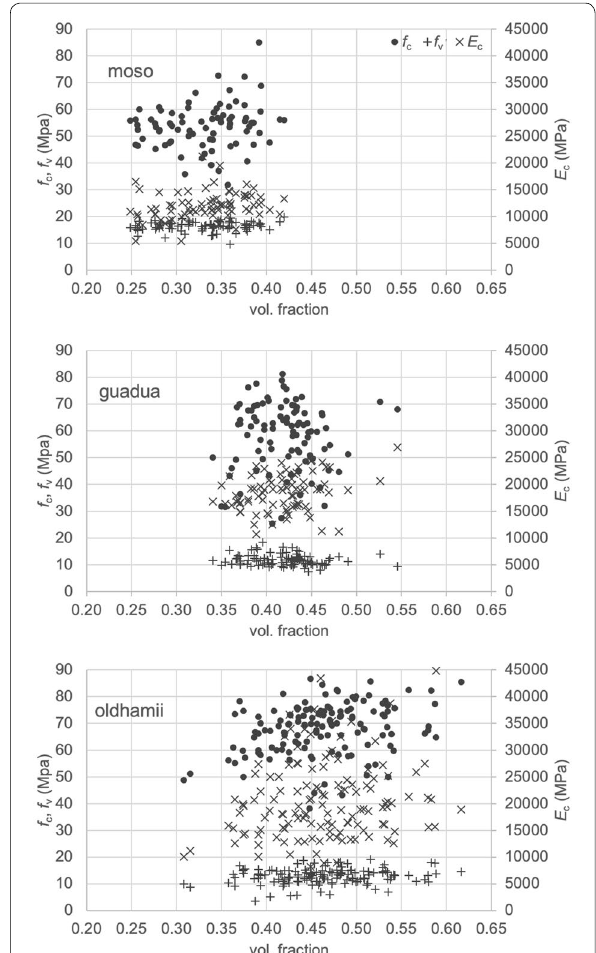
Fig. 10 Correlation between volume faction and mechanical